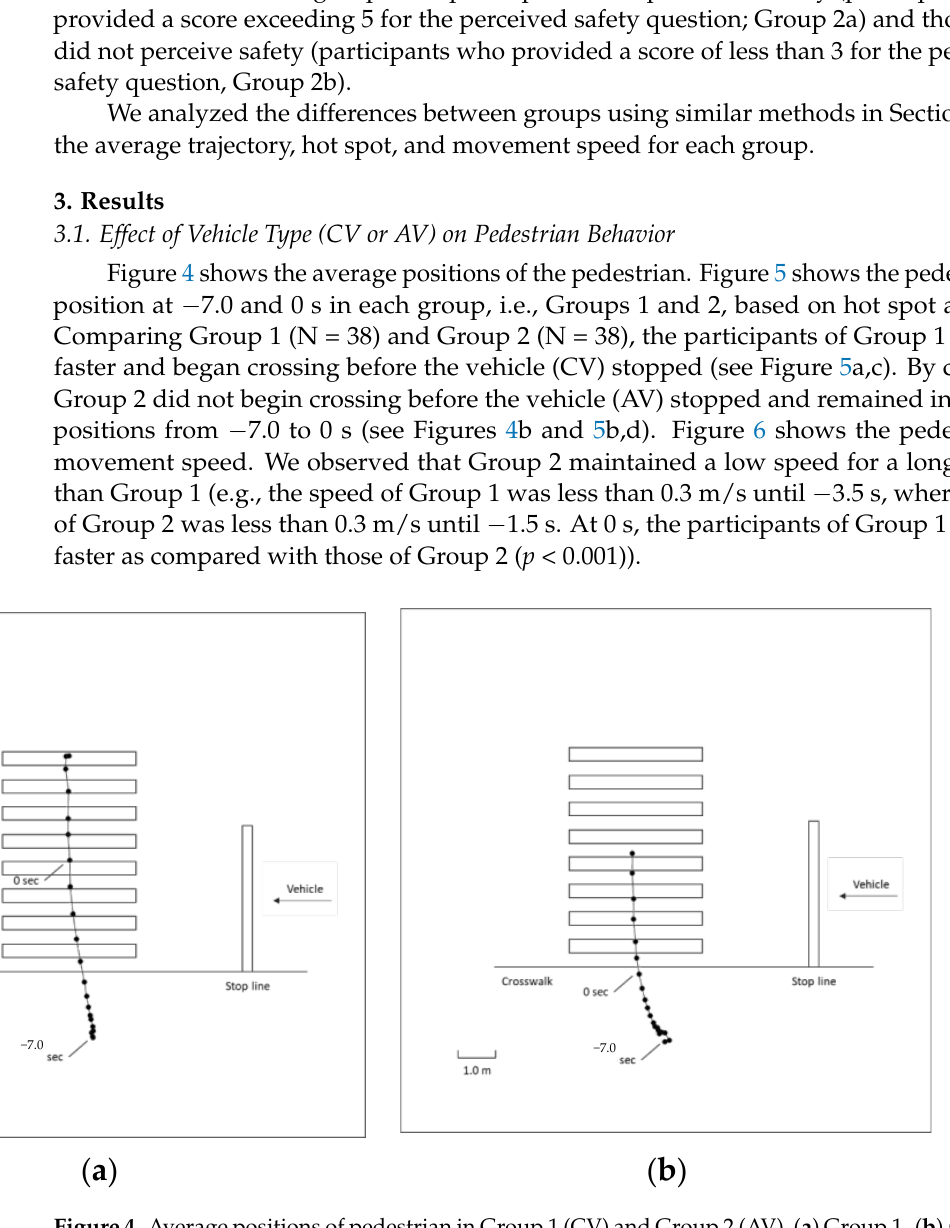
Figure 4. Average positions of pedestrian in Group 1 (CV) and Group 2 (AV). ( a ) Group 1. ( b ) Group 2.